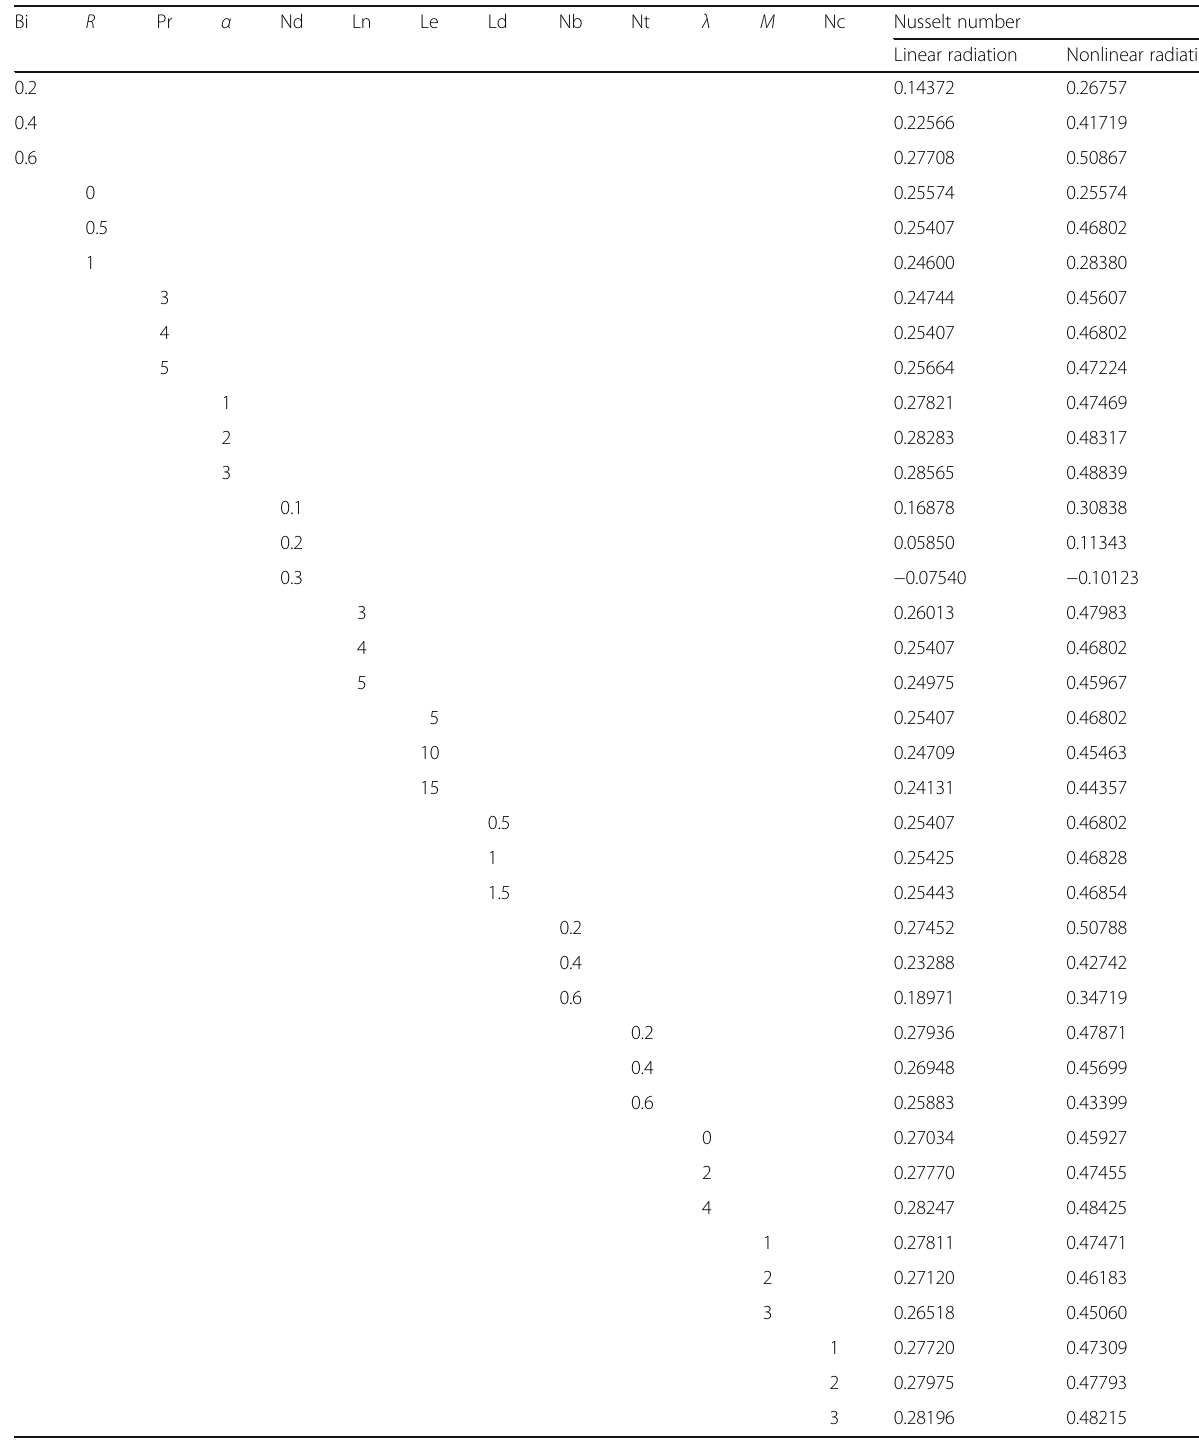
Table 6 The numerical values of skin friction coefficient with different physical parameters with linear and nonlinear radiation